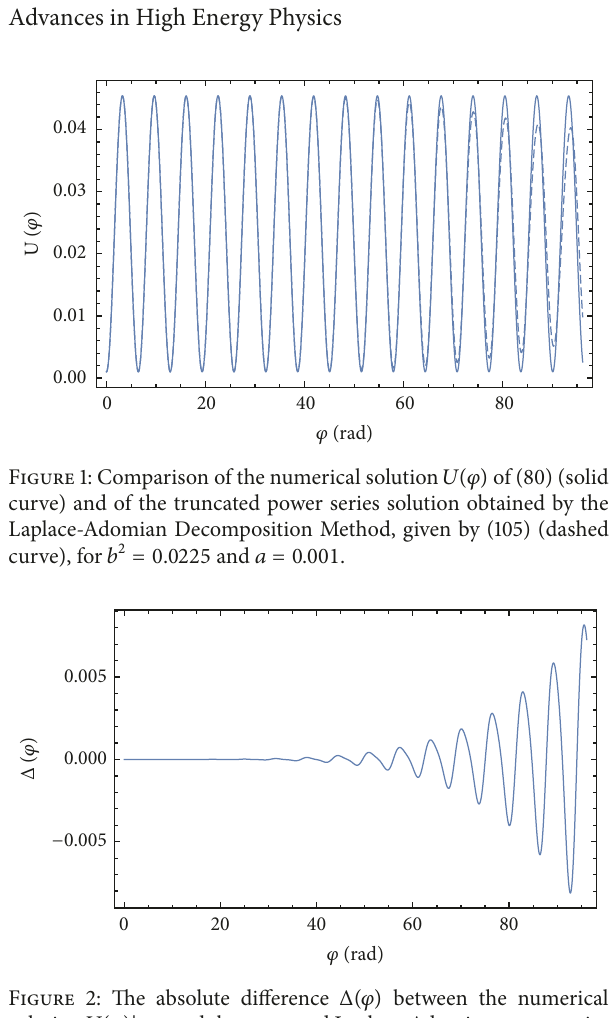
In the case of the planet Mercury its orbital parameters 11 are 𝑎 = 57.91 × 10 cm and 𝑒 = 0.205615 , respectively.